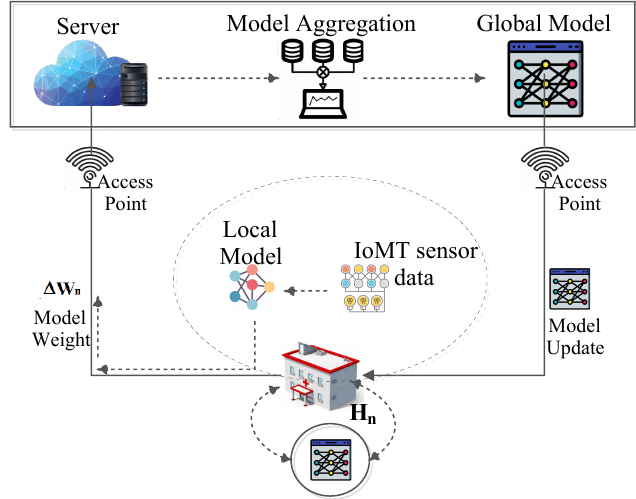
Figure 4. FL-IoMT architecture and communication process